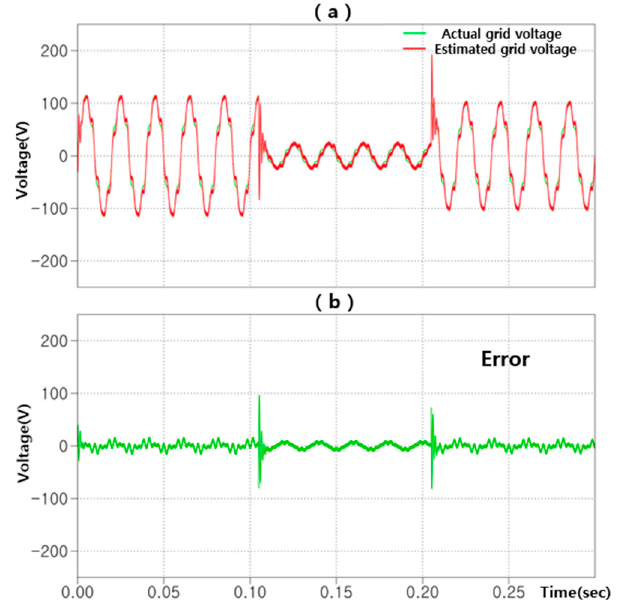
Figure 6. Simulation results of measured actual grid voltage and estimated grid voltage through the single-phase grid current observer, (a) actual and estimated grid voltage (b) error between actual and grid voltage.